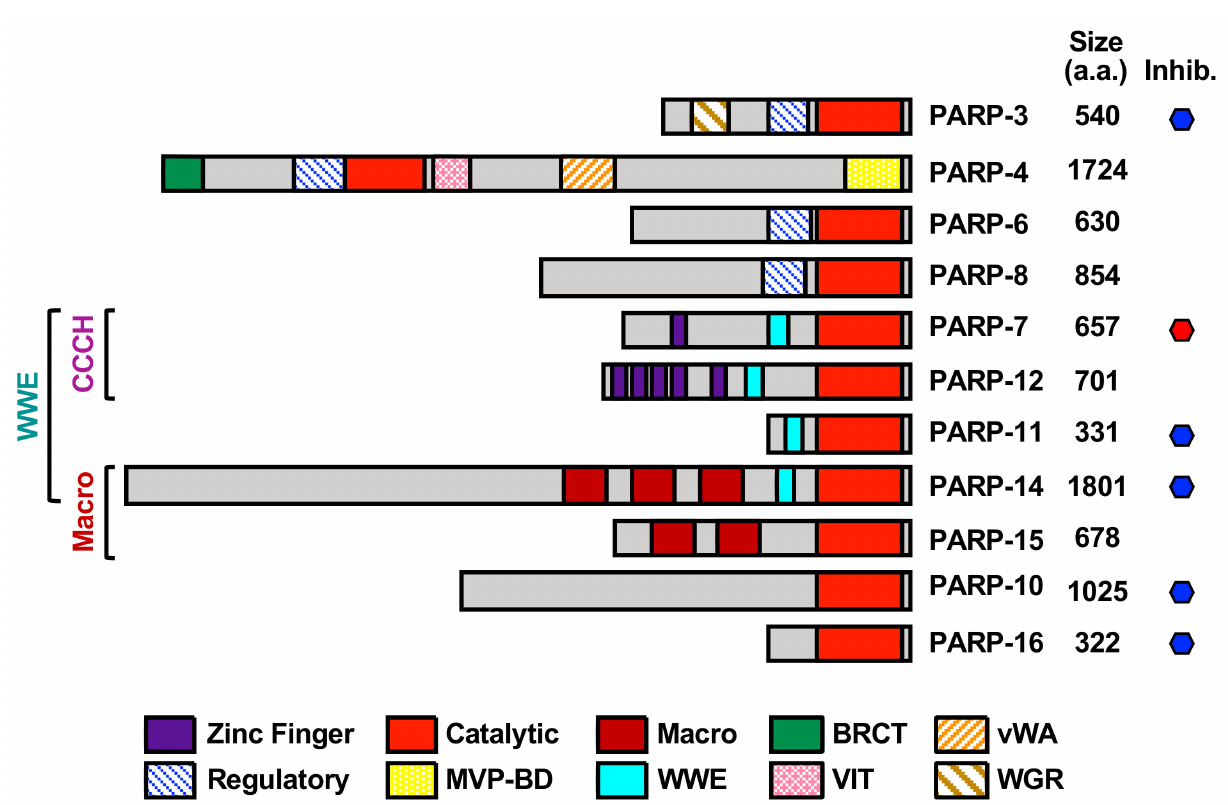
Figure 1. Structural and functional organization of mono(ADP-ribosyl) transferases (MARTs). Schematic representations of human MARTs depicting key structural and functional domains. The MARTs have been categorized based on the presence of CCCH zinc fingers, tryptophan-glutamate (WWE) motifs, and macrodomains in the proteins. The domains shown are MVP-BD (major vault protein-binding domain); BRCT (BRCA1 C-terminal domain); VIT (vault inter-trypsin domain); RRM (RNA Recognition Motif); WGR (tryptophan-glycine-arginine-rich domain); and vWA (von Willebrand factor type A domain). The MARTs that have known inhibitors (inhib.) are indicated with a hexagon (red = in clinical trials, blue not yet in clinical trials). Other non-cytosolic or non-MART members of the poly(ADP-ribosyl) polymerase (PARP) family are not shown: PARP-1, PARP-2, and PARP5a/b (nuclear polyenzymes); PARP-9 and PARP-13 (catalytically inactive). PARP-3 is a MART, but is primarily nuclear. The size of each protein (in amino acids, a.a.) is drawn to scale, but the position and size of the functional domains is